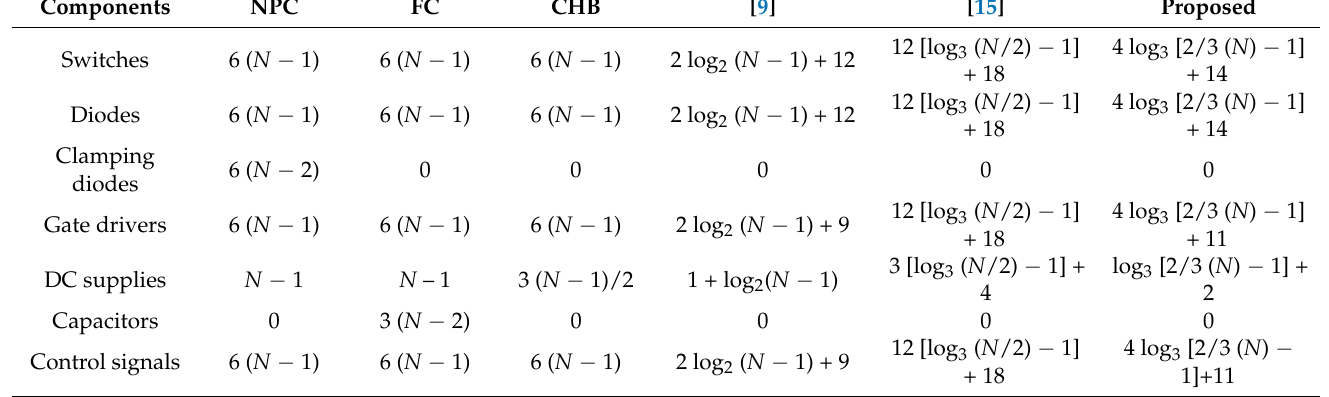
Table 3. Comparative analysis between different multilevel inverter topologies in terms of voltage levels.